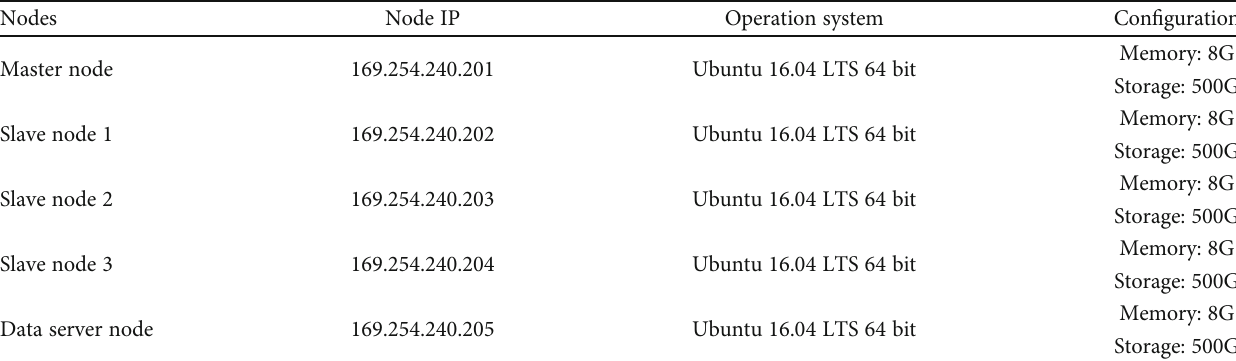
Table 2: The details of all